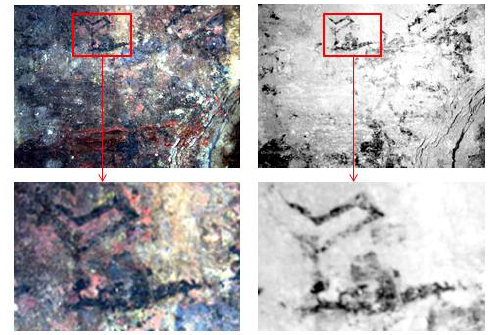
Figure7. Comparison of formula (2) before and after